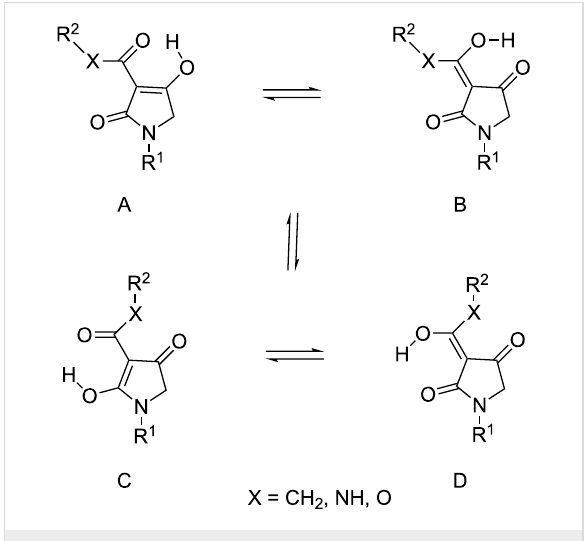
Figure 2: Tautomerism of tetramates.